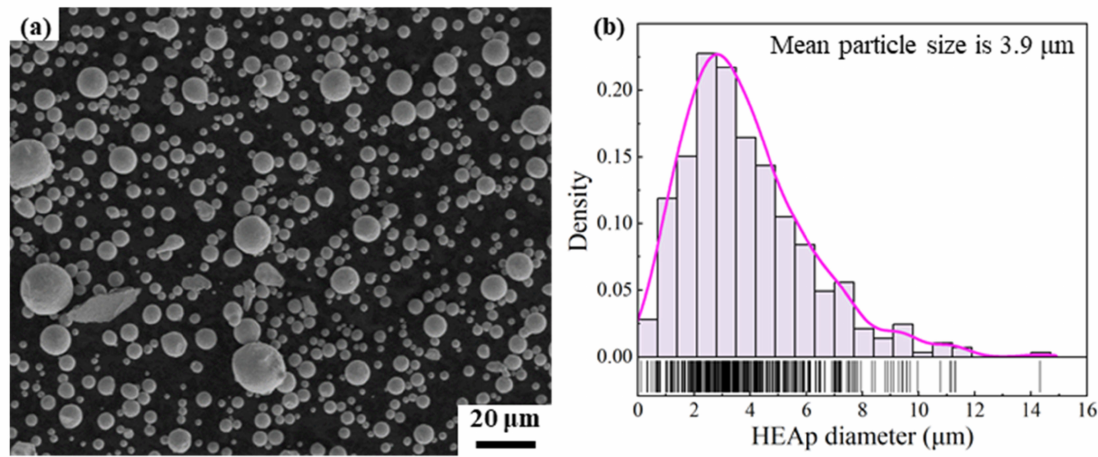
Figure 1. ( a ) SEM images of HEAp morphology. ( b ) Statistical diagram of particle size distribution of high entropy